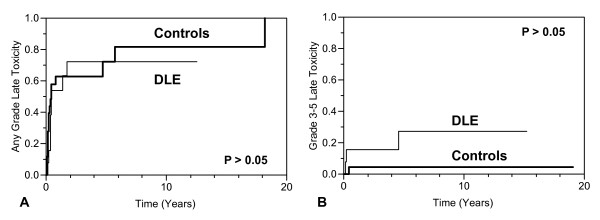
Kaplan-Meier estimates of any grade (A) and grade 3-5 (B) late toxicity with DLE patient treatment courses (n = 13) and control patient treatment courses (n = 26). Log-Rank p-values were > 0.05 for both comparisons.